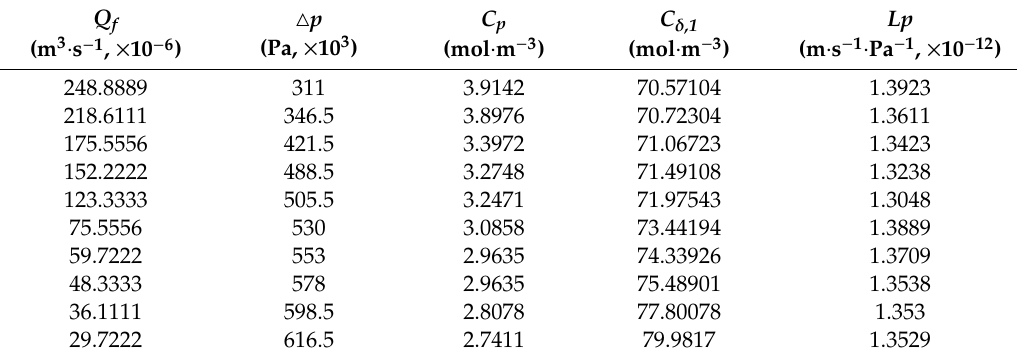
Table 2. Solute concentration at the membrane surface ( C f = 70.17 mol·m − 3 , pH = 6, T = 306 K, R = 8.314 J·mol − 1 ·K − 1 ).